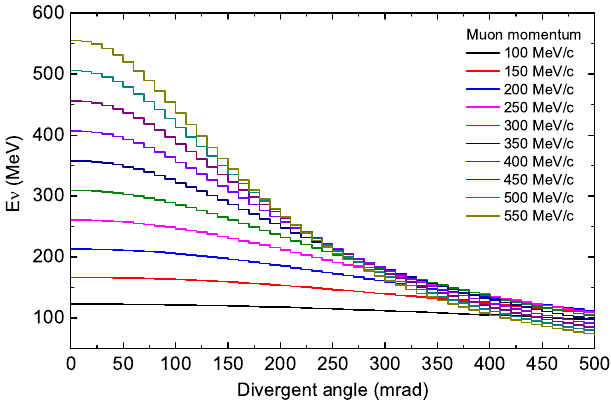
FIG. 17. Neutrino energy dependence on the divergent angle and momentum of a muon (this figure needs to be changed with “ divergent angle ” ).